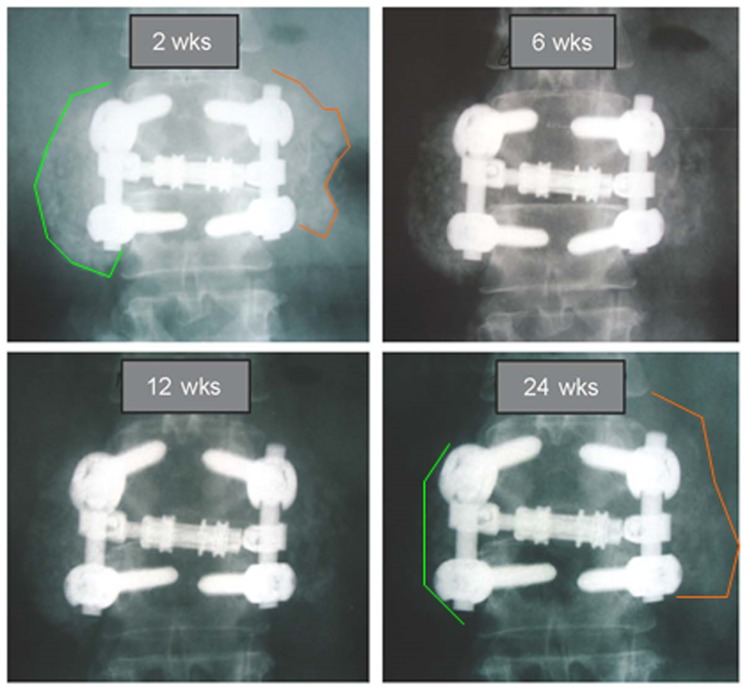
Comparative radiography depicting resorption and consolidation of two bone graft extenders. A 46-year-old female with history of active tobacco use and diabetes underwent PL fusion of the lumbar spine at L2-3 and L5-S1. AP radiographs at L2-3 are shown over time. Left side received bone autograft, BMA, and β-TCP putty. Right side received equal mix of bone autograft, BMA, and InQu putty. Sequential assessment over 24 weeks illustrates marked resorption of ceramic bone graft, whereas the opposite side receiving hybrid extender showed consolidation of applied graft at 6 weeks, with sustained bone volume at 24 weeks.